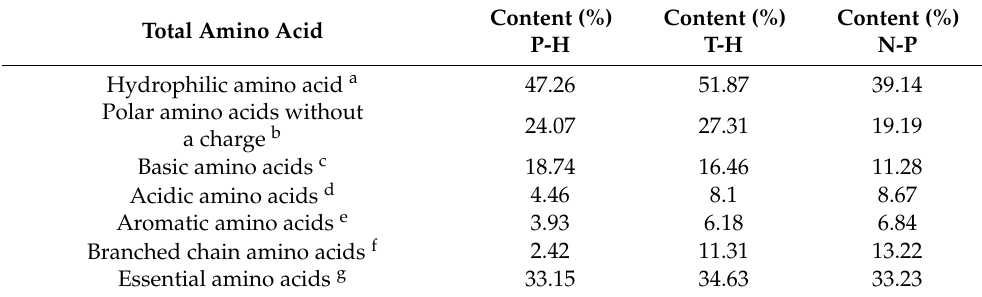
Table 1. Amino acid composition of three P. crocea